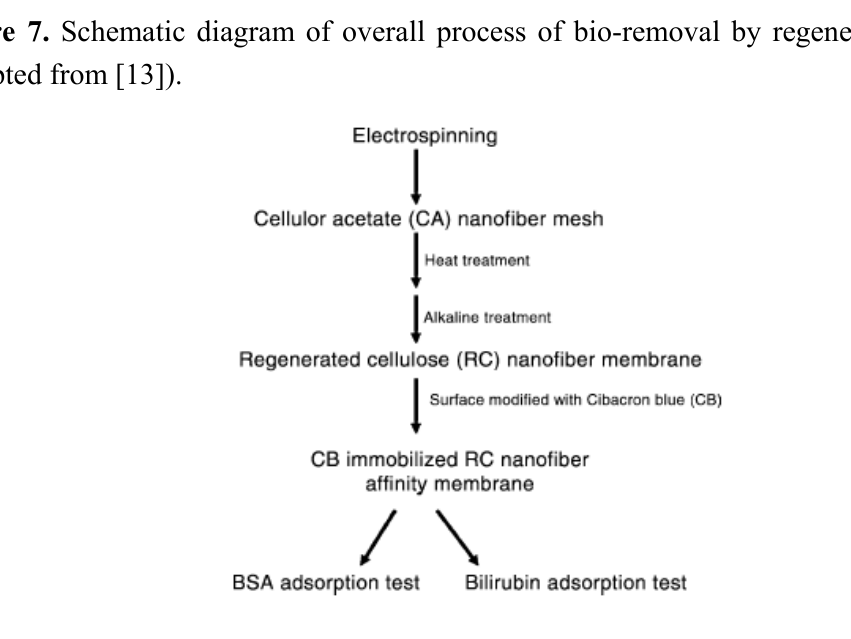
Figure 8. FESEM pictures of electrospun PVDF membrane (a) before separation, (b) after 10 µm, (c) after 5 µm, and (d) after 1 um polystyrene particle separation (Adapted from